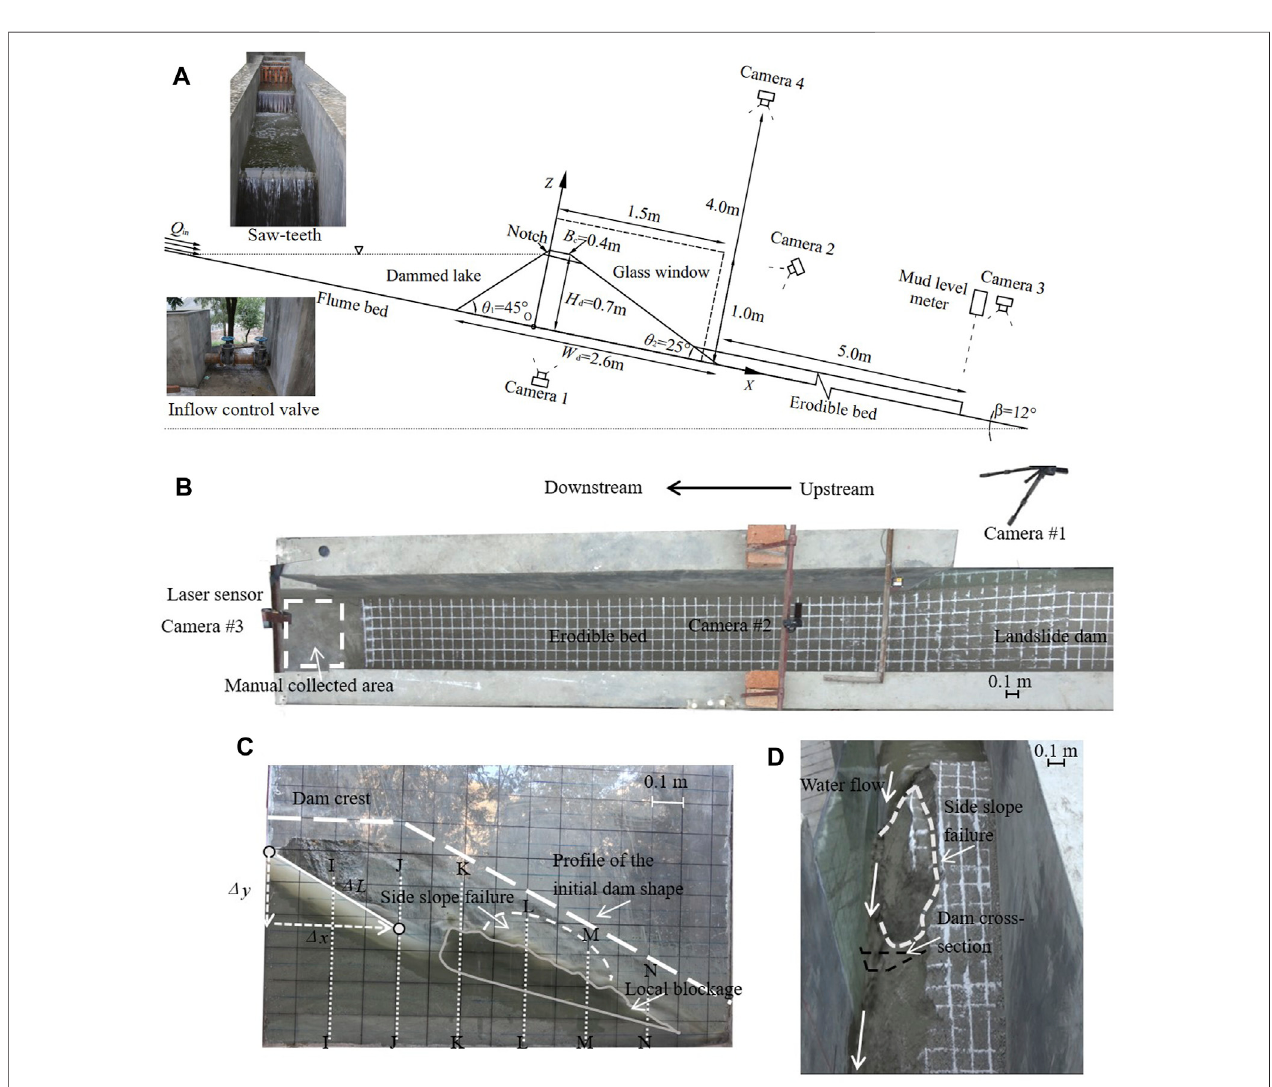
FIGURE2|(A) Schematicdiagram ofthemodel damwiththeexactdimensions (B) anillustration ofthelargedebris fl ow fl umeinDDFORS(10 mlong,0.7 mwide and 1.4 m deep, inclined at 12 ° to the horizontal) as viewed from camera #4 (C) a side-view from of the model dam as viewed from the side region of the fl ume from